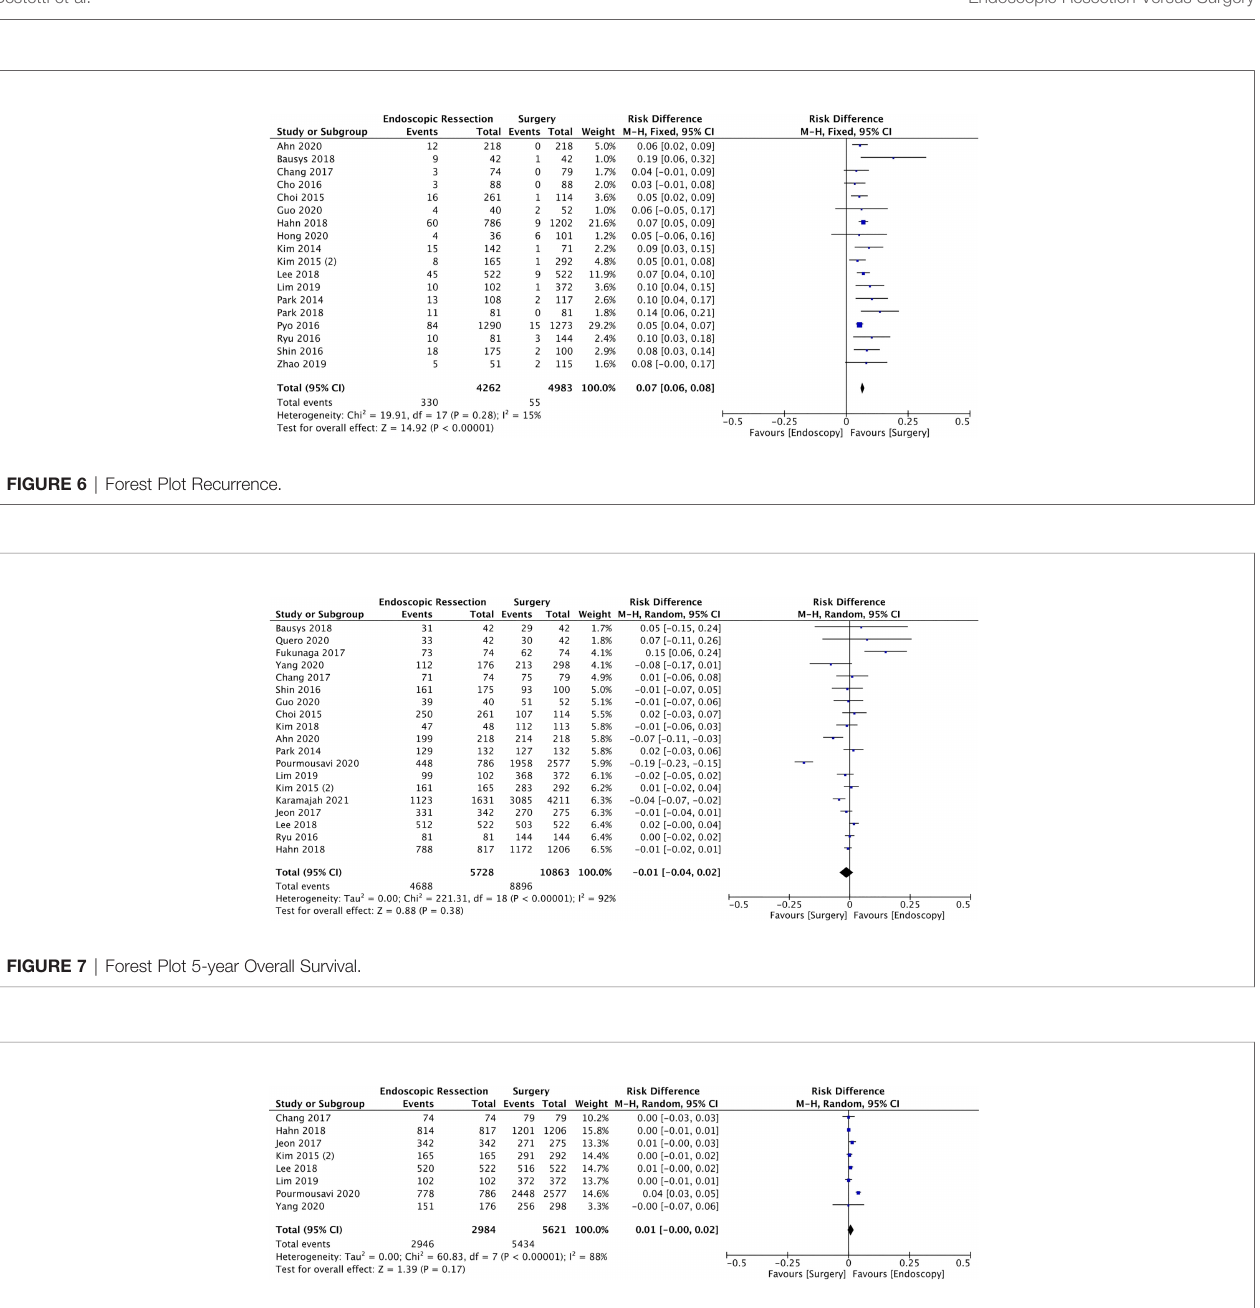
FIGURE 8 | Forest Plot 5-year Cancer Speci fi c